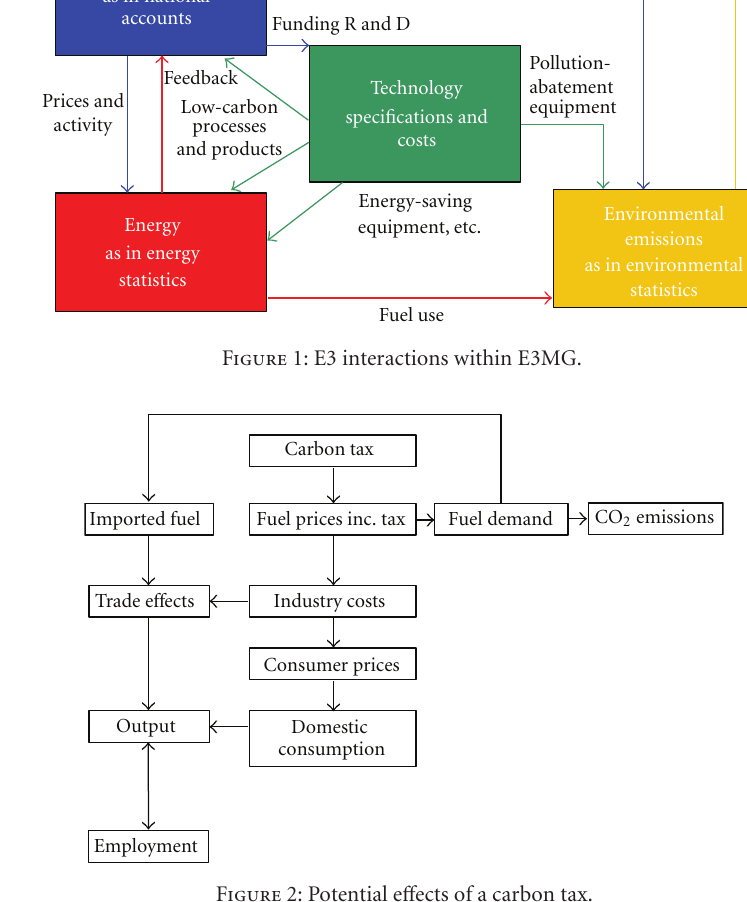
Figure 2: Potential e ff ects of a carbon tax.